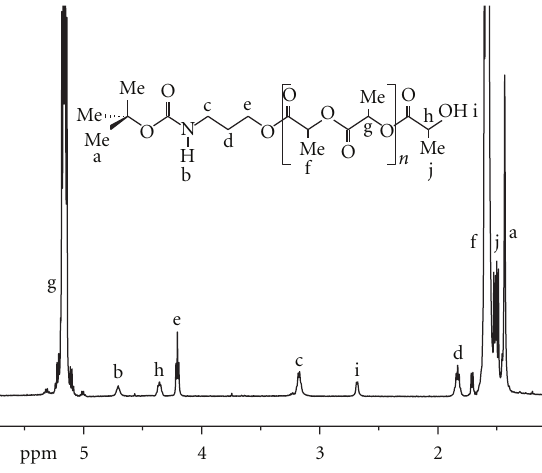
Figure 3: 1 NMR spectra of BocNH-PLLA in CDCl 3